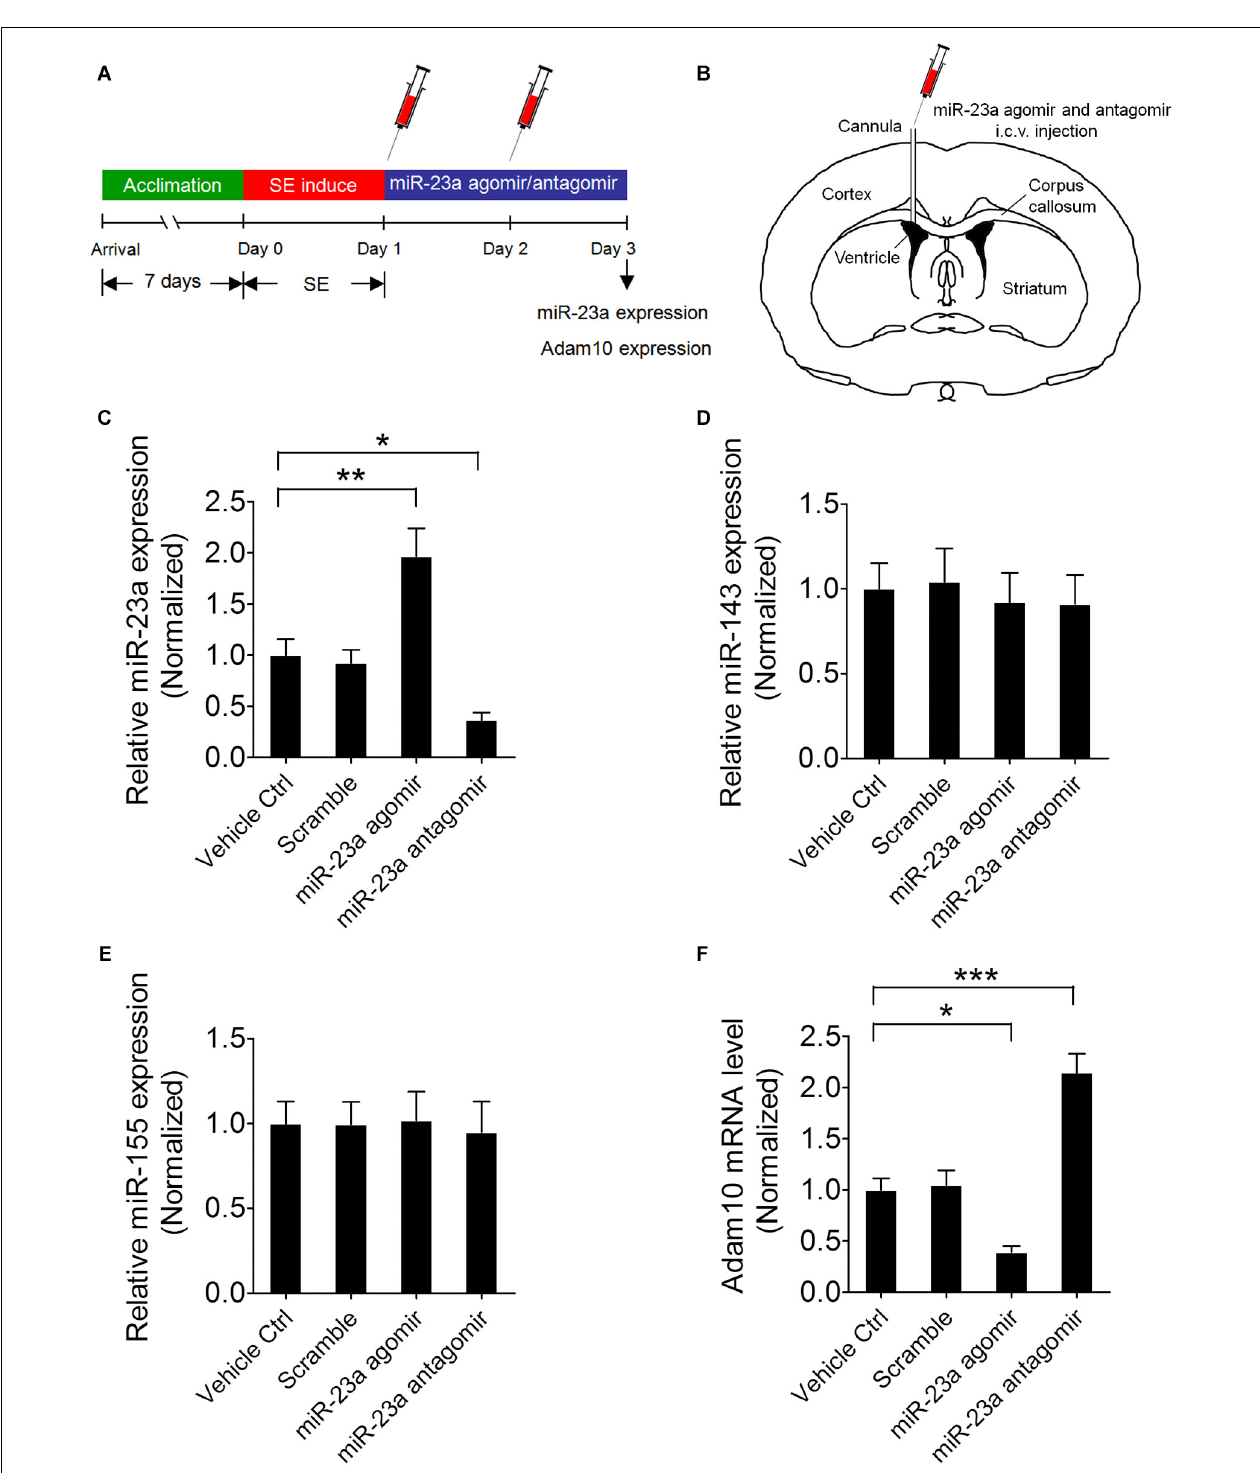
FIGURE 4 | miR-23a down-regulates hippocampal ADAM10 mRNA level in TLE mice. (A) Schematic diagram of the experimental design. Mice were treated with a miR-23a agomir or miR-23a antagomir immediately after SE two times at 24 h interval and investigated miR-23a and ADAM10 expression levels 48 h after SE. (B) Schematic diagram of intracerebroventricular (i.c.v.) injection of miR-23a agomir or miR-23a antagomir into the lateral ventricle (LV). (C–F) qRT-PCR analysis of miR-23a ( F 3 , 16 = 14.66, p = 0.006, miR-23a agomir vs. vehicle ctrl; p = 0.048, miR-23a antagomir vs. vehicle ctrl), miR-143, miR-155, and ADAM10 ( F 3 , 16 = 29.87, p = 0.025, miR-23a agomir vs. vehicle ctrl; p < 0.001, miR-23a antagomir vs. vehicle ctrl) mRNA level in the hippocampus of vehicle ctrl, scramble, miR-23a agomir, and miR-23a antagomir-treated TLE mice ( n = 5). Values are mean ± SEM. ∗ p < 0.05, ∗∗ p < 0.01, ∗∗∗ p < 0.001, one-way ANOVA.